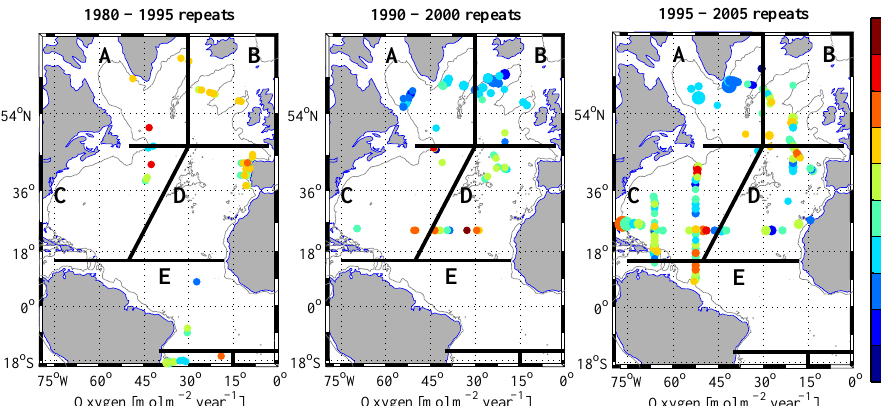
Fig. 9. Same as Fig. 7 but for storage rates (molm − 2 a − 1 ) of oxygen.